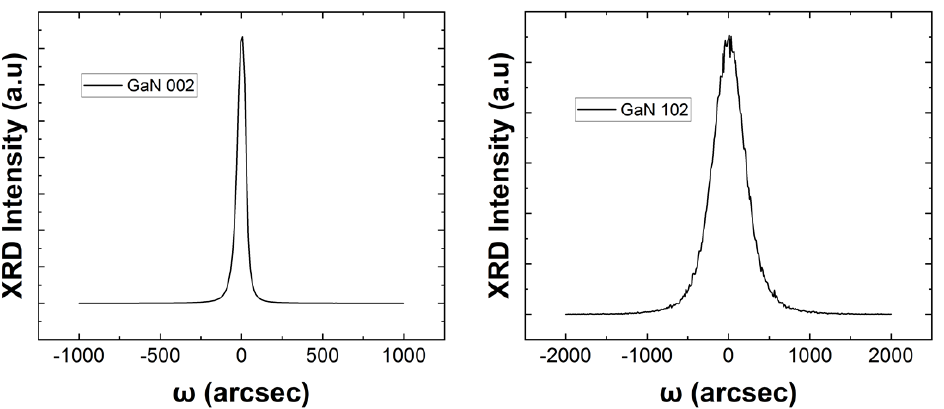
Figure 5. The symmetric (002) and asymmetric (102) rocking curves of GaN grown on the sapphire substrate with am AlN buffer by using the MOCVD